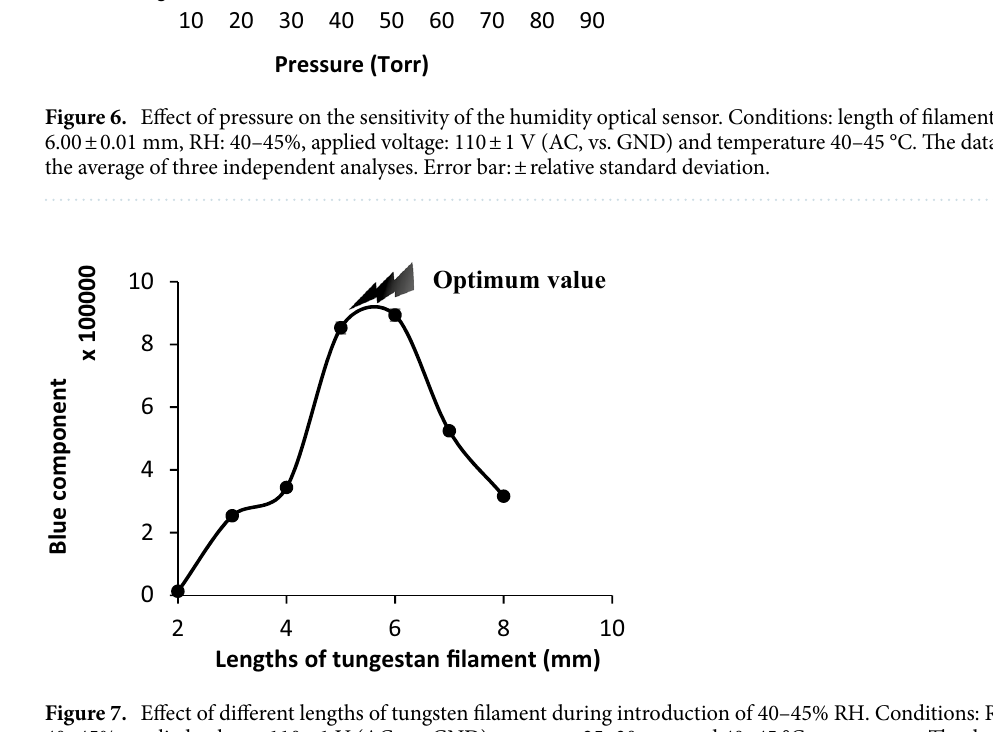
Figure 7. Effect of different lengths of tungsten filament during introduction of 40–45% RH. Conditions: RH: 40–45%, applied voltage: 110 ± 1 V (AC, vs. GND), pressure: 25–30 torr, and 40–45 °C temperature. The data are the average of three independent analyses. Error bar: ± relative standard